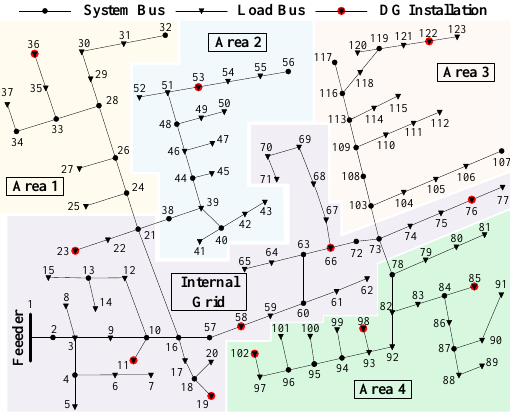
Figure 5. Modified IEEE 123-node system.